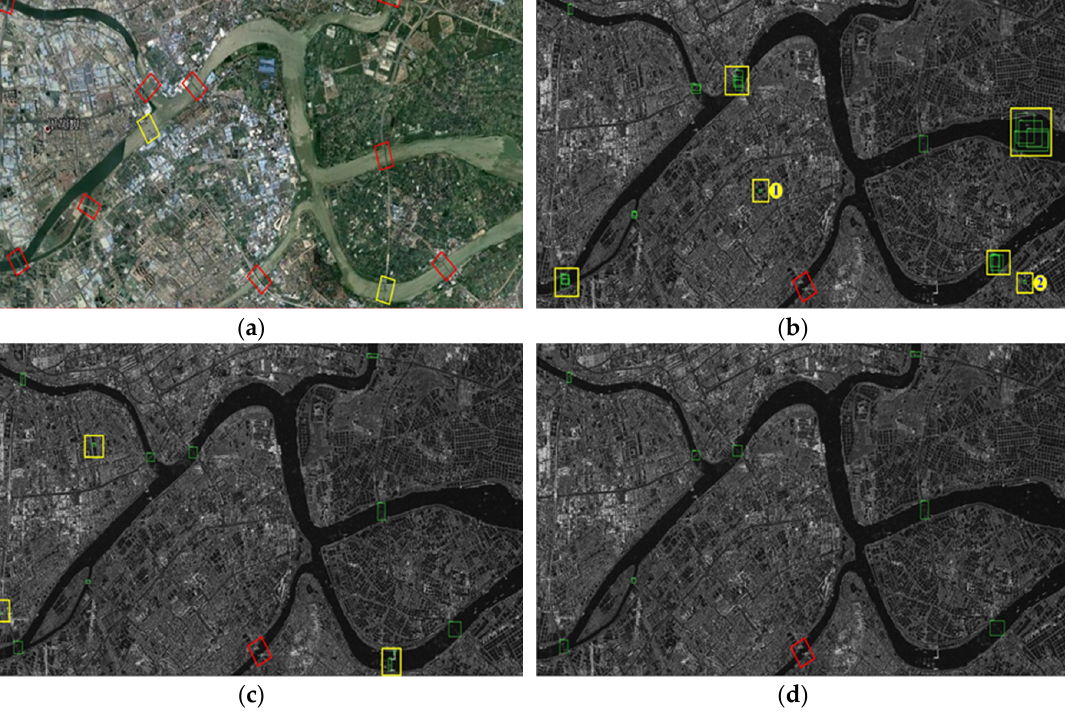
Figure 11. The corresponding Optical image and detected results of bridges by different networks for Scene 2. ( a ) the corresponding optical image of Scene 2. ( b ) the detected result of bridges by Faster R-CNN. ( c ) the detected result of bridges by SSD. ( d ) the detected result of bridges by MABN.